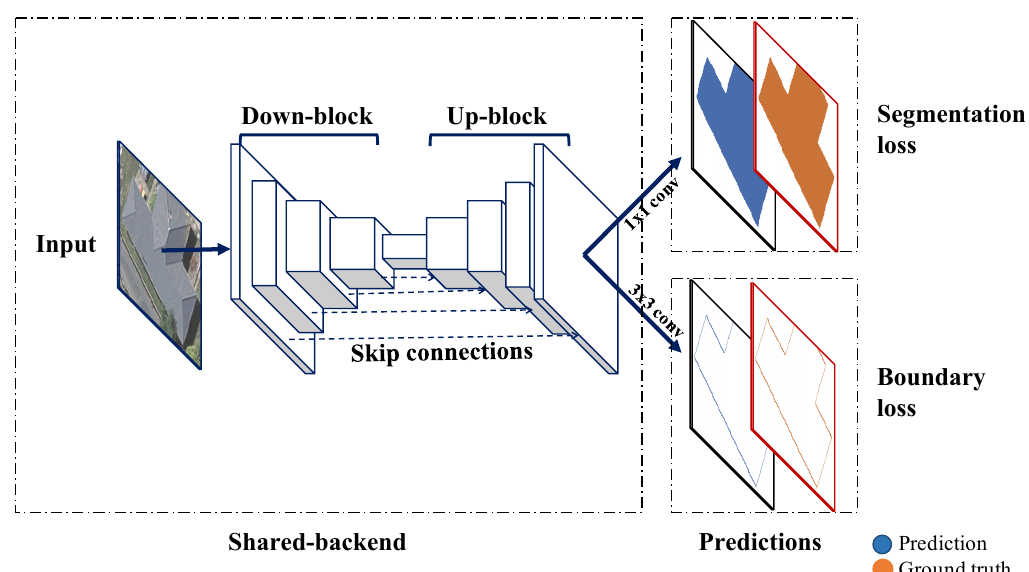
Figure 3. The network architecture of the proposed BR-Net model. The BR-Net model adopts a modified U-Net structure as a shared backend and performs multitask predictions for roof segmentation and outline